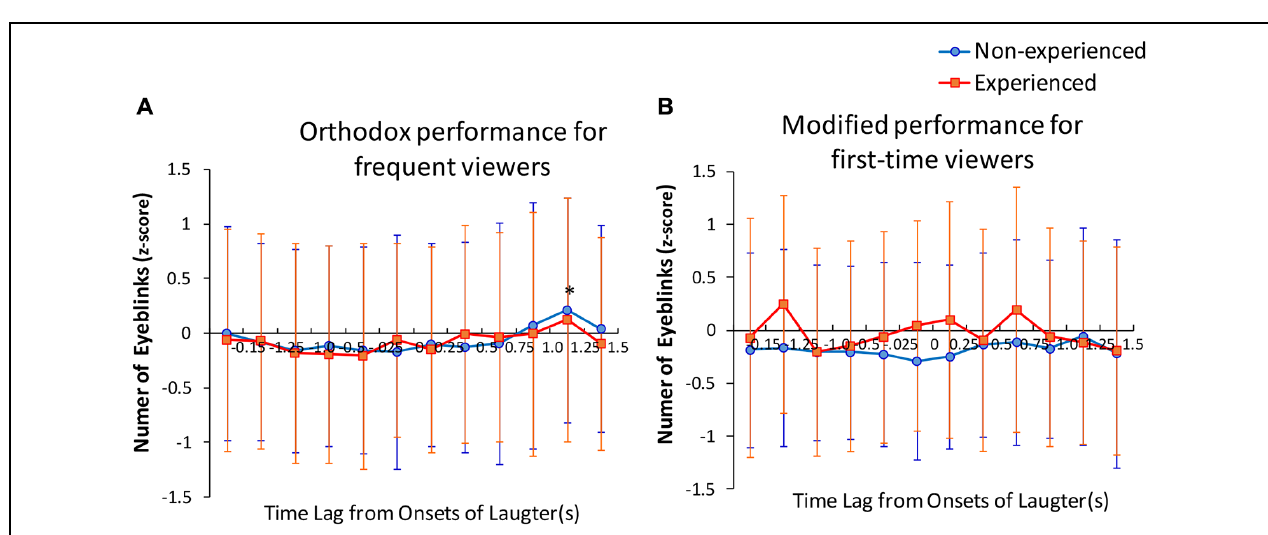
FIGURE 2 | (A,B) Asynchrony of eyeblinks among participants at each scene (5 min) during appreciation of videotaped performance (A) , which is orthodox for frequent viewers, and (B) , which is modified for first-time viewers. Mean D interval among all possible pairs within each group were calculated. Error bars shows